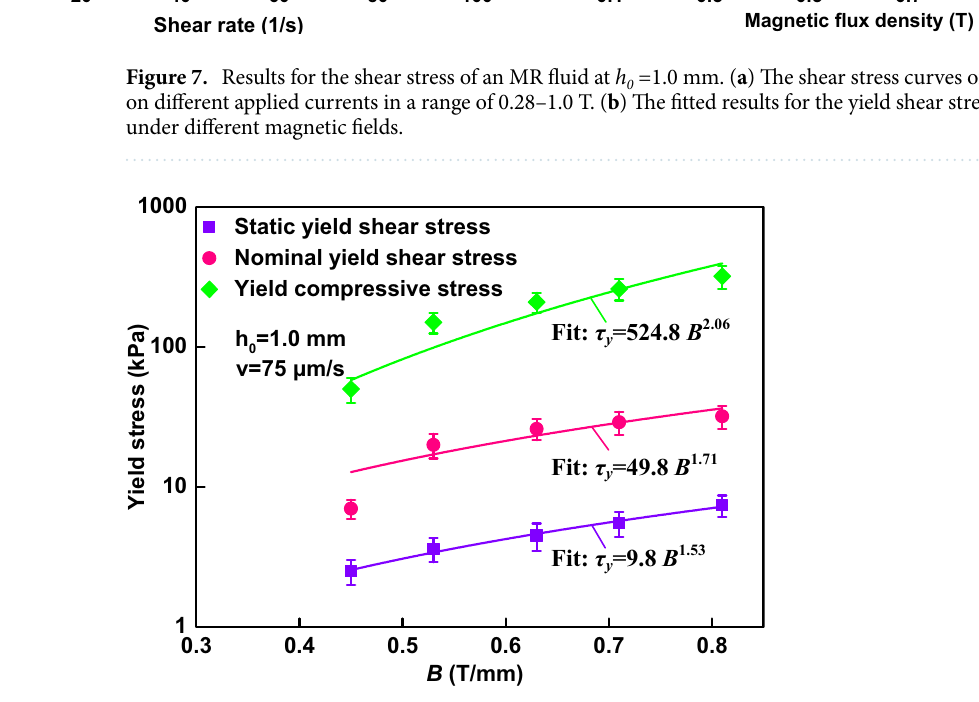
Figure 8. Comparison among yield compressive stresses, nominal yield shear stresses and static yield shear stresses at h 0 =1.0 mm v = 75